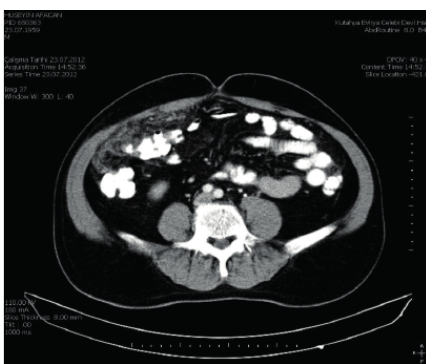
Figure 3: 7 × 5 cm mass originating from the gallbladder.